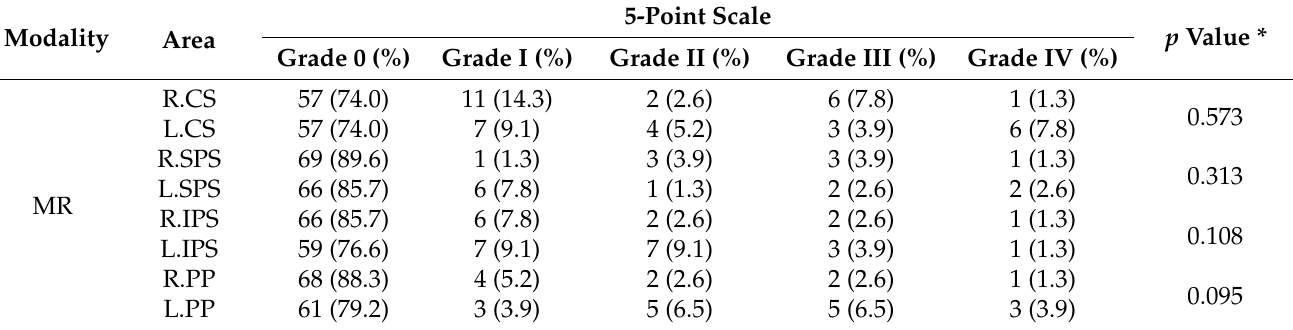
Table A1. Frequency of flow-related signal intensity in CS, SPS, IPS, and PP by grading in 77 participants (cohort 2). Modality